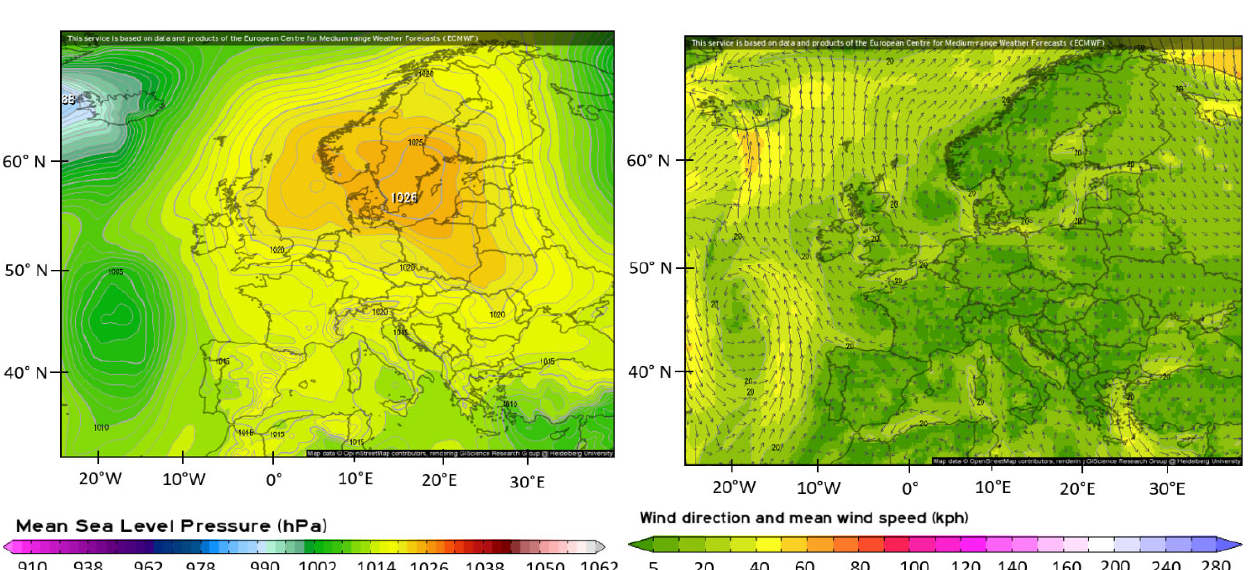
Figure 6. Sea ‐ level pressure (left) and 10 m wind directions and speeds by ECMWF reanalysis for 15 December 2021. On the left, colors indicate the mean sea ‐ level pressure and lines highlight the isobars. On the right, arrows indicate the wind direction and the colors indicate the wind speeds. Source: (meteorologix.com, accessed on 8 February 2023). Sea/land breeze situations are established because there is a difference in temperature between the sea and the land. During SB, sea surface temperatures were around 23.0 °C and 15.0 °C for SB and WB, respectively, whereas, the temperature maxima over the con ‐ tinent at LAV were 27.9 °C and 16.8 °C for SB and WB, respectively. During SB, land breezes occurred during nighttime, blowing from the northeast sector with relatively low wind speed values below 2 m/s. The land and the sea breezes had the same direction dur ‐ ing summer; however, the sea breezes lasted shorter than the land breezes.